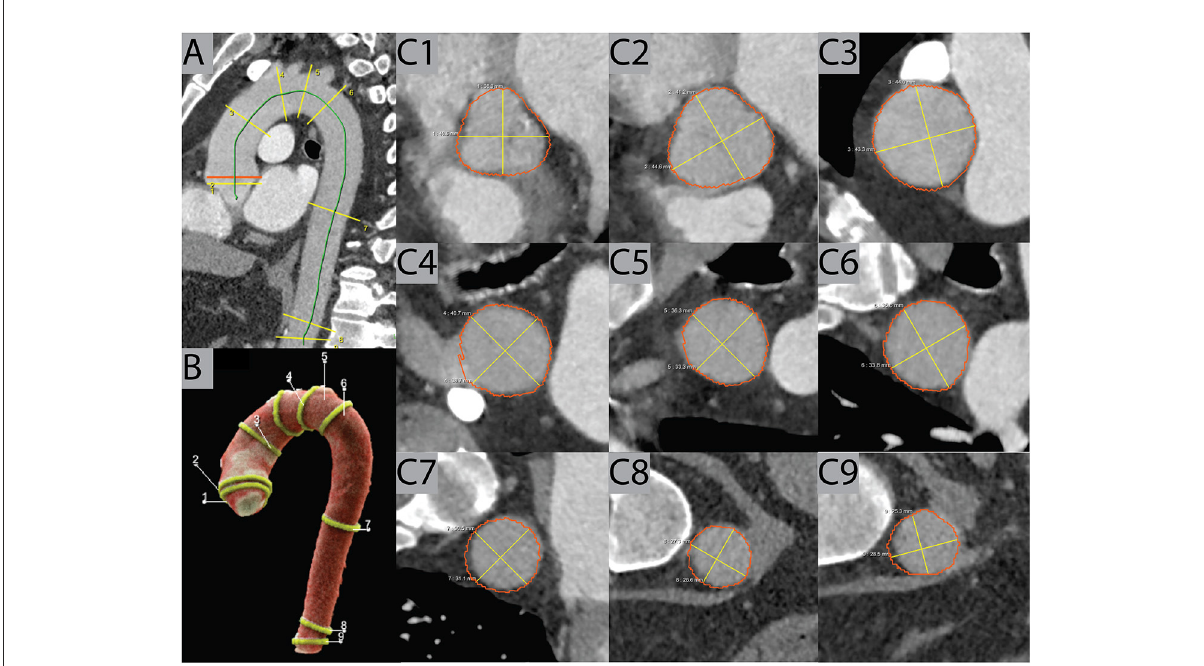
FIGURE2 Example case. AIRad produced visual outputs consisting of a sagittal view on the thoracic aorta (A) and a 3D volume rendering (B) with all measured locations (C1–C9) . Furthermore, images of the measurements perpendicular to the centerline at each of the nine locations according to the AHA guidelines were also created, as seen in this example of an exam in pulmonary-arterial phase. AHA, American Heart